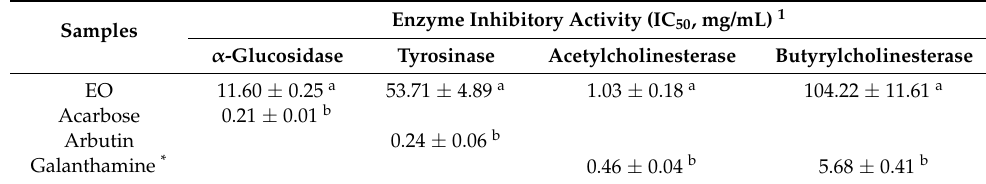
Table 3. The enzyme inhibitory activity of R. beesianus rhizome EO.